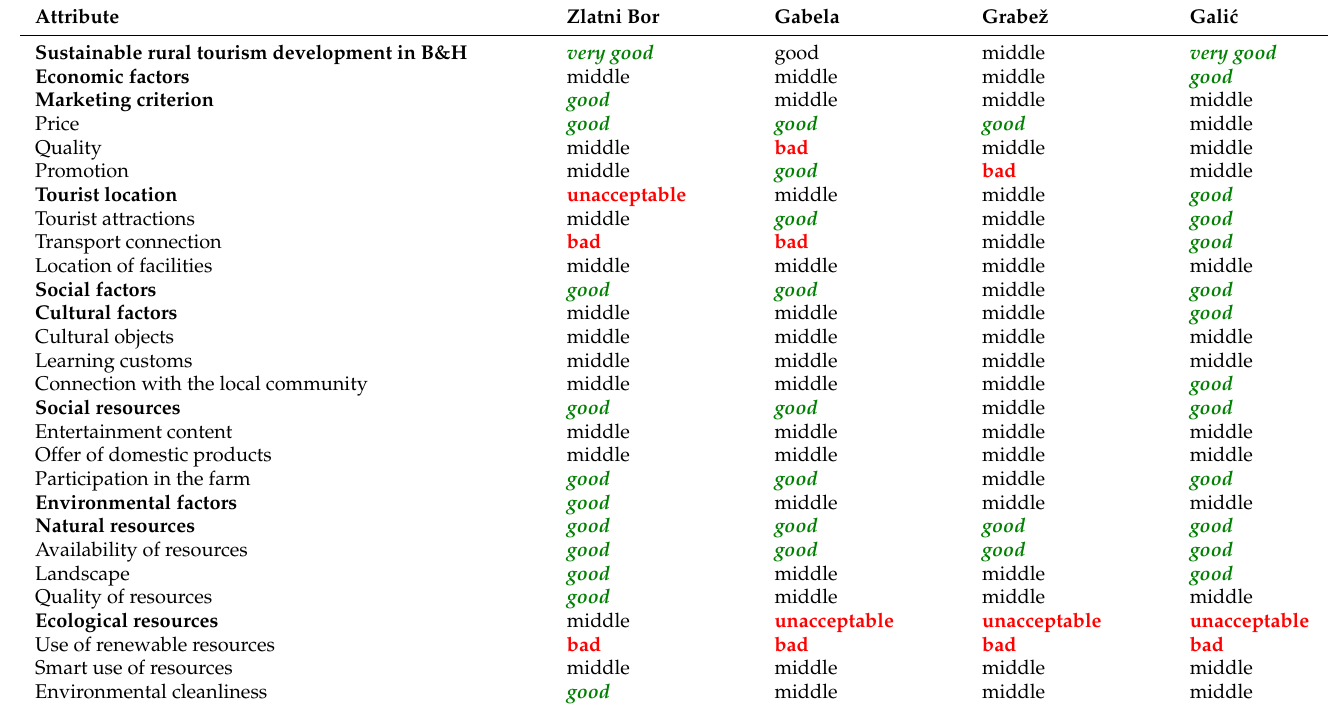
Table 2. Gradings of the selected BIH rural tourism